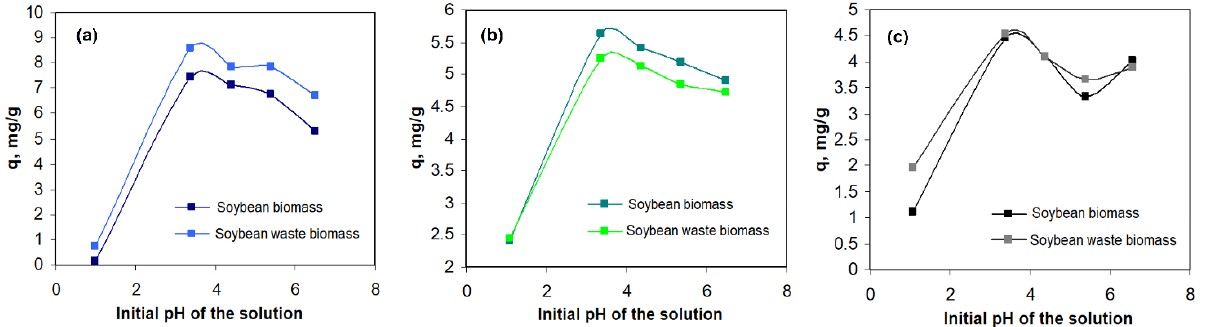
Figure 4. Variation of the biosorption capacity of the two biosorbents (soybean biomass and soybean waste biomass) with the initial pH of the solution in the case of the retention of ( a ) Pb(II), ( b ) Cd(II), and ( c ) Zn(II) ions.